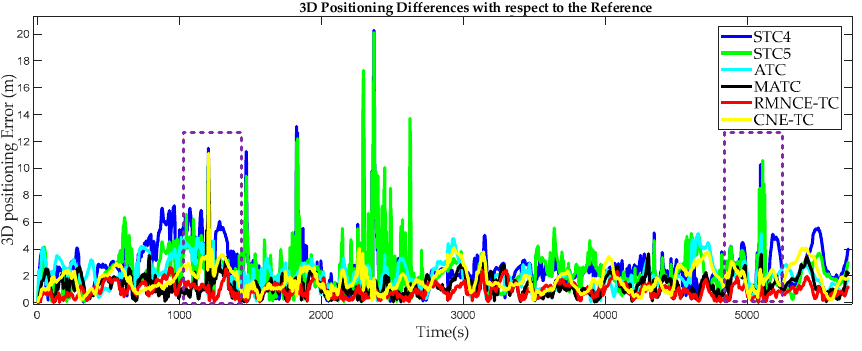
Figure 13. 3D positioning differences of the test schemes with respect to the reference trajectory.